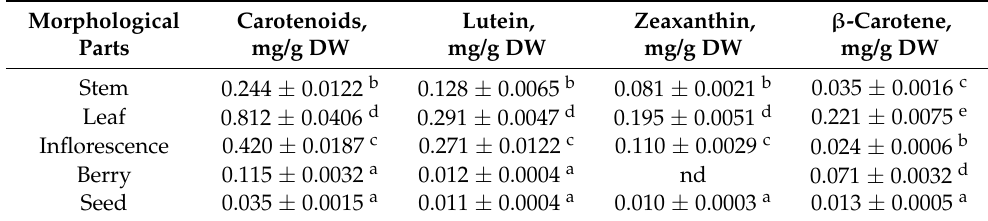
Table 4. The total and individual carotenoid content (mg/g DW) of A. cordata morphological parts. Morphological Carotenoids, Lutein, Parts mg/g DW mg/g